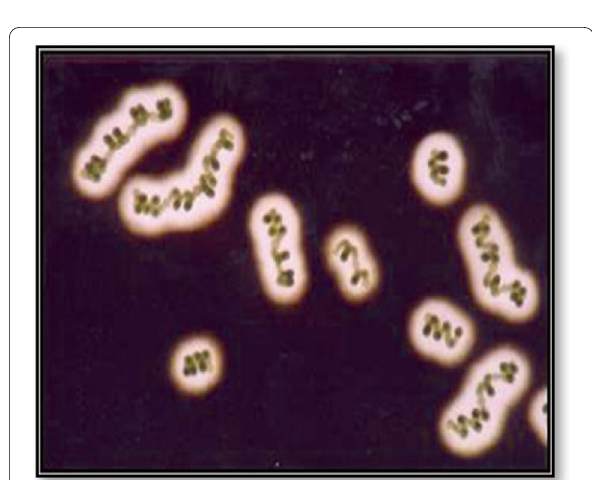
Fig. 4 The exopolysaccharides of Cyanospira capsulata